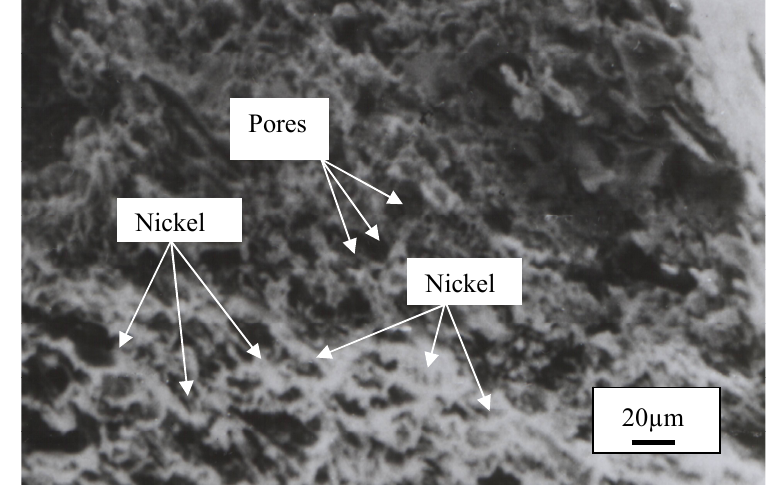
Figure 8 – SEM photomicrograph of the fracture morphology of the Ni-25% graphite coating deposited with 700A sa